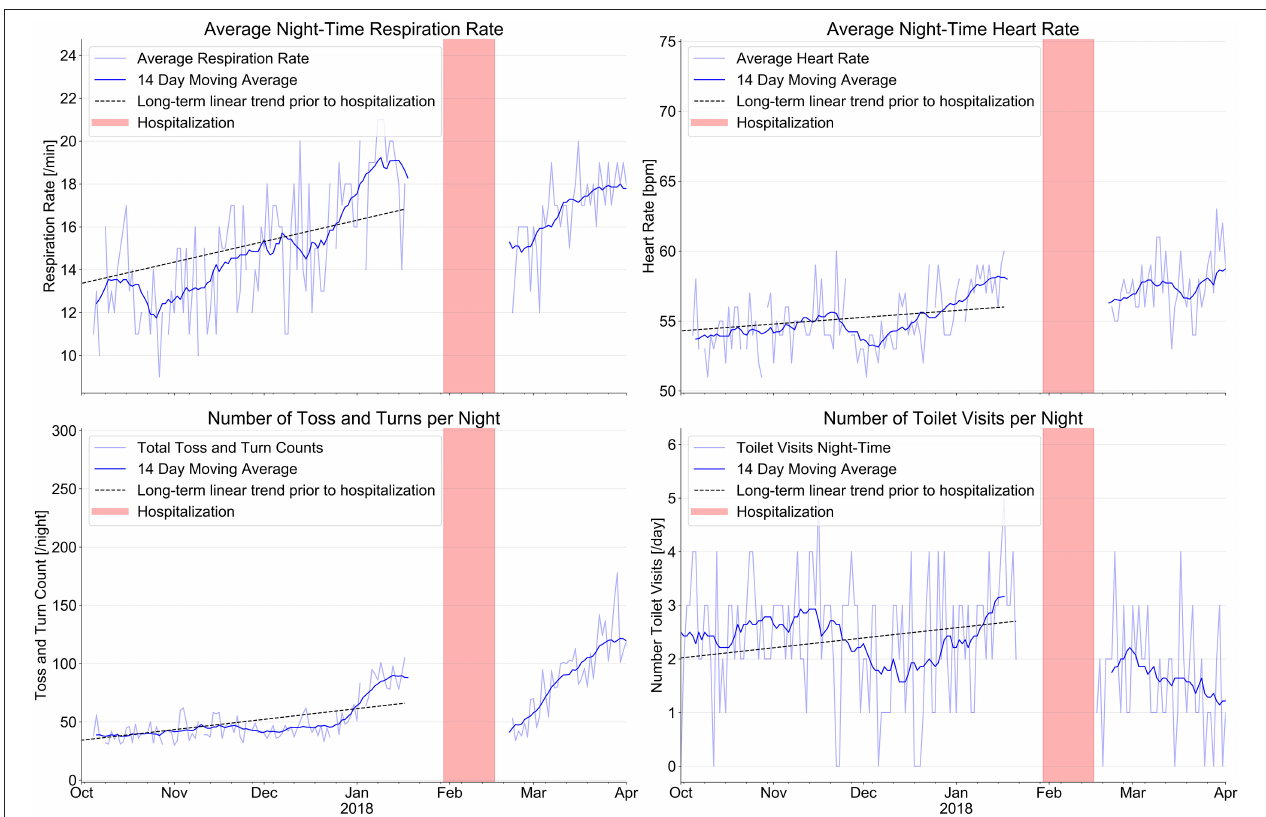
FIGURE 1 | Evolution of sensor signals from a combined ambient passive infrared motion sensor system to monitor the number of toilet visits at night with an EMFIT QS bed sensor device. The combination of signals from the various sensors before hospitalization indicate signs of increasing heart failure decompensation long before the index event on January 30 th 2018 (red bars indicate hospitalization). After hospital discharge, sensor signals indicate improvement of all parameters.